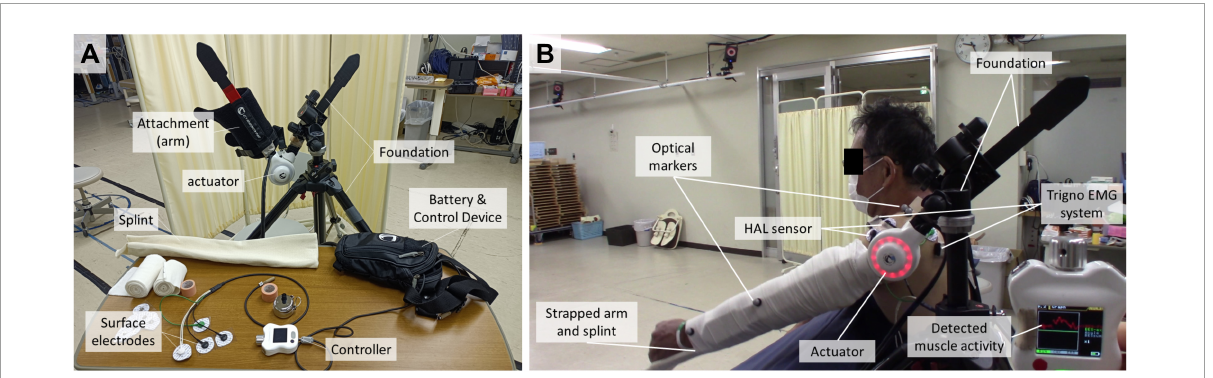
FIGURE1 Single-joint type HAL. (A) Apparatus set up. (B) Fixation for shoulder rehabilitation on the